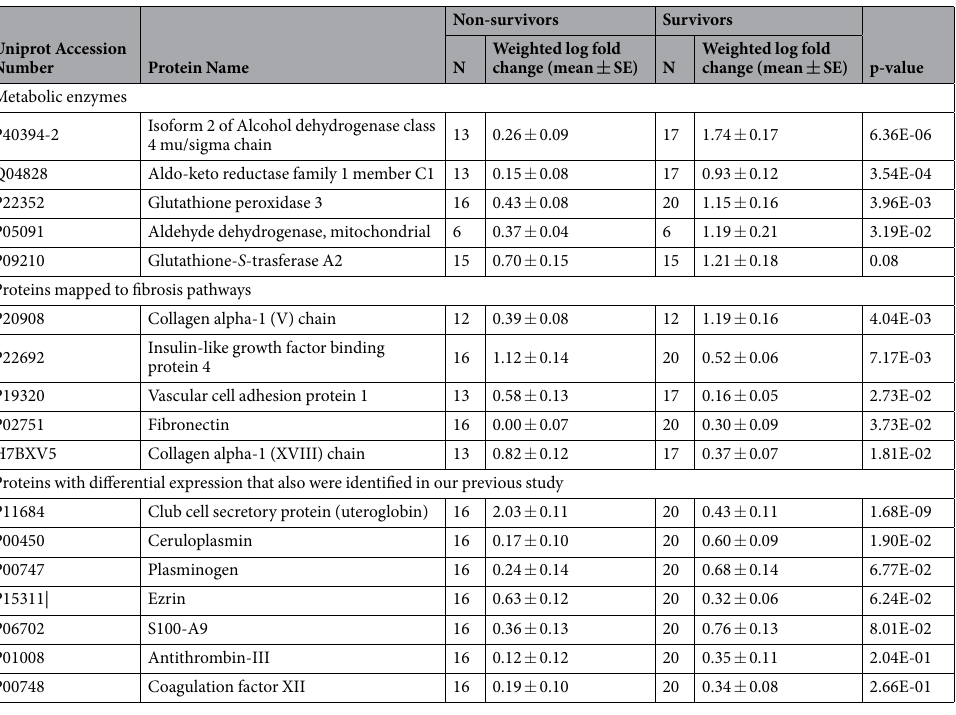
Table 4. Proteins of Interest that Demonstrate a Difference in Expression between Survivors and Non- Survivors in Low